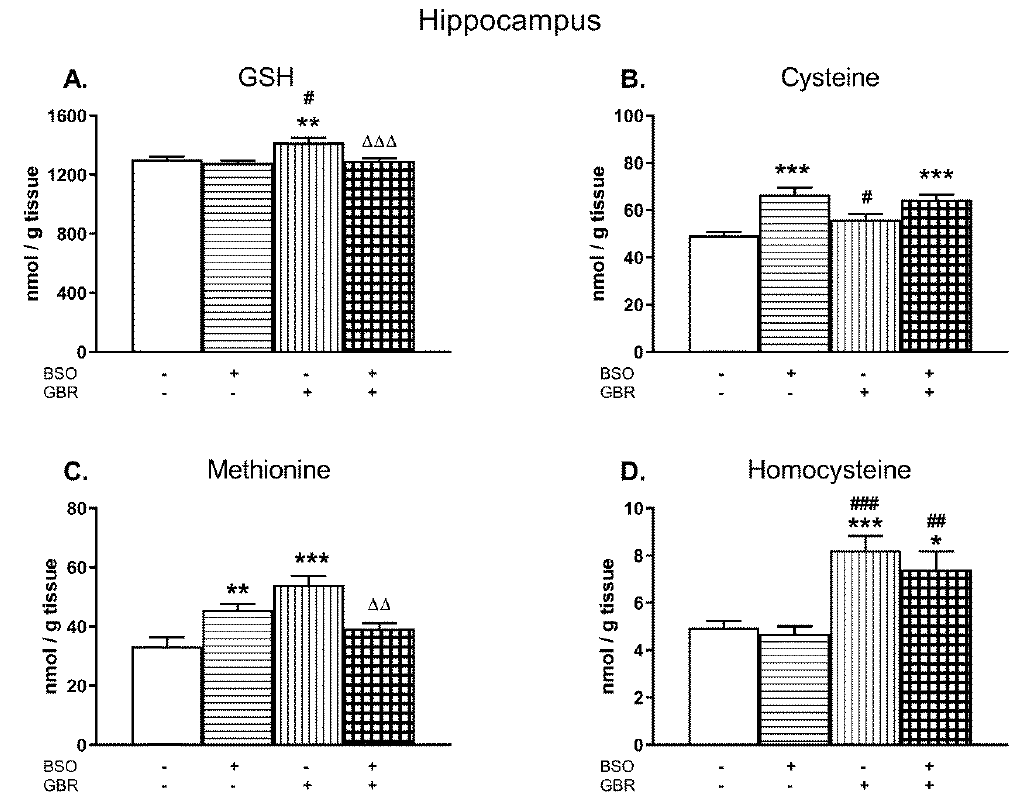
Figure 4. The effects of chronic administration of BSO and GBR 12909, alone or in combination, on the levels of GSH ( A ), Cys ( B ), Met ( C ), and Hcy ( D ) in the HIP of 16-day-old rats. Data expressed in nmole/g of tissue are presented as the mean ± SEM, n = 8 for each group. Statistical analysis was performed using a two-way ANOVA; symbols indicate significance of differences according to the Newman–Keuls post-hoc test, * p < 0.05, ** p < 0.01, *** p < 0.001 vs. control; # p < 0.05; ## p < 0.01, ### p < 0.001 vs. BSO-; and ∆∆ p < 0.01, ∆∆∆ p < 0.001 vs. GBR 12909-treated groups.